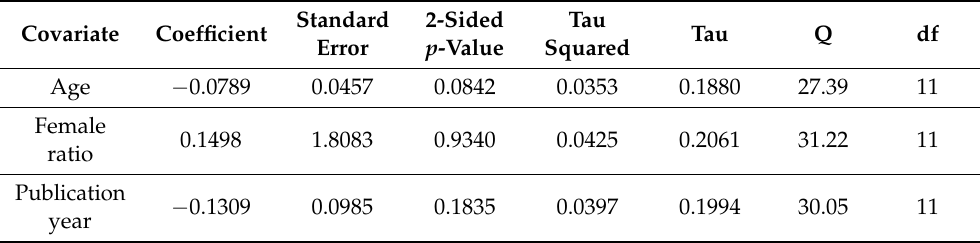
Table 3. Results of meta-regressions for probable